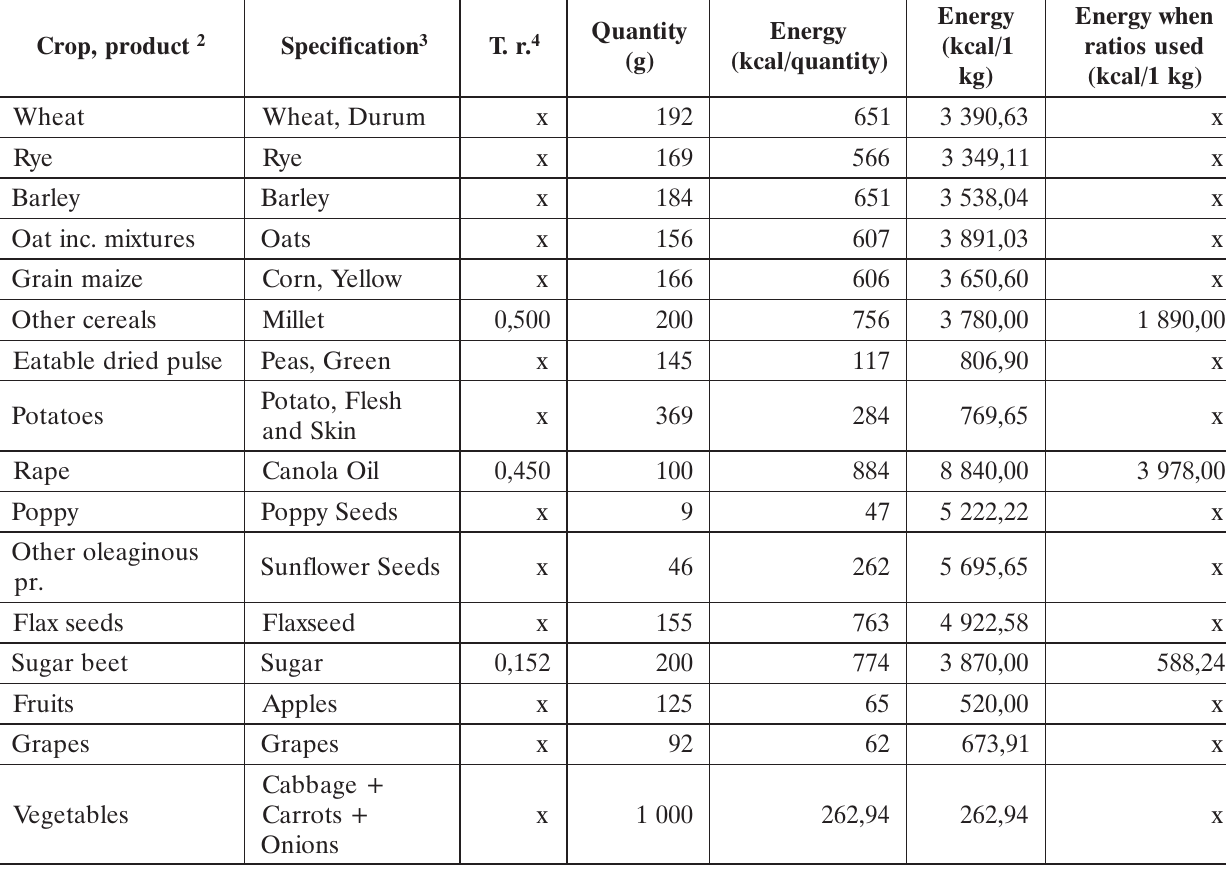
Table 2. Commodity energy value [4, 5]